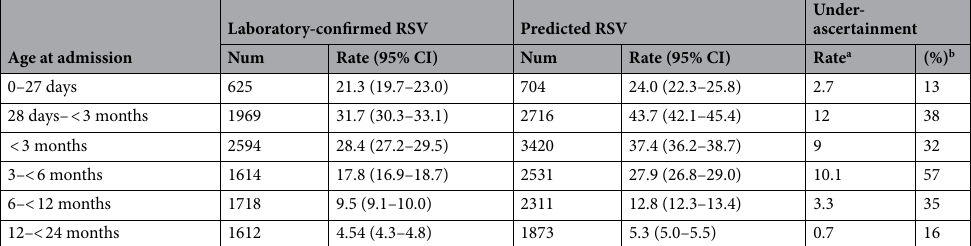
Table 2. Incidence rates of laboratory-confirmed and predicted RSV positivity by age at hospital admission, 2000–2012. All rates presented in this table are per 1000 child-years. a Rate differences (per 1000 child-years) between lab-confirmed and predicted RSV. b Percentage differences between rates of